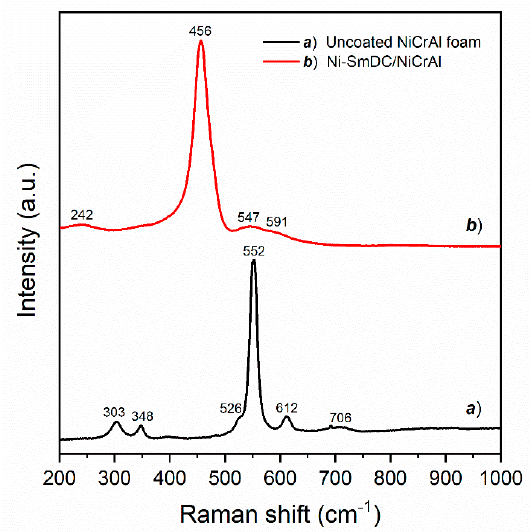
Figure 4. Raman spectra of ( a ) NiCrAl foam and ( b ) Ni-SmDC / NiCrAl structured catalyst.